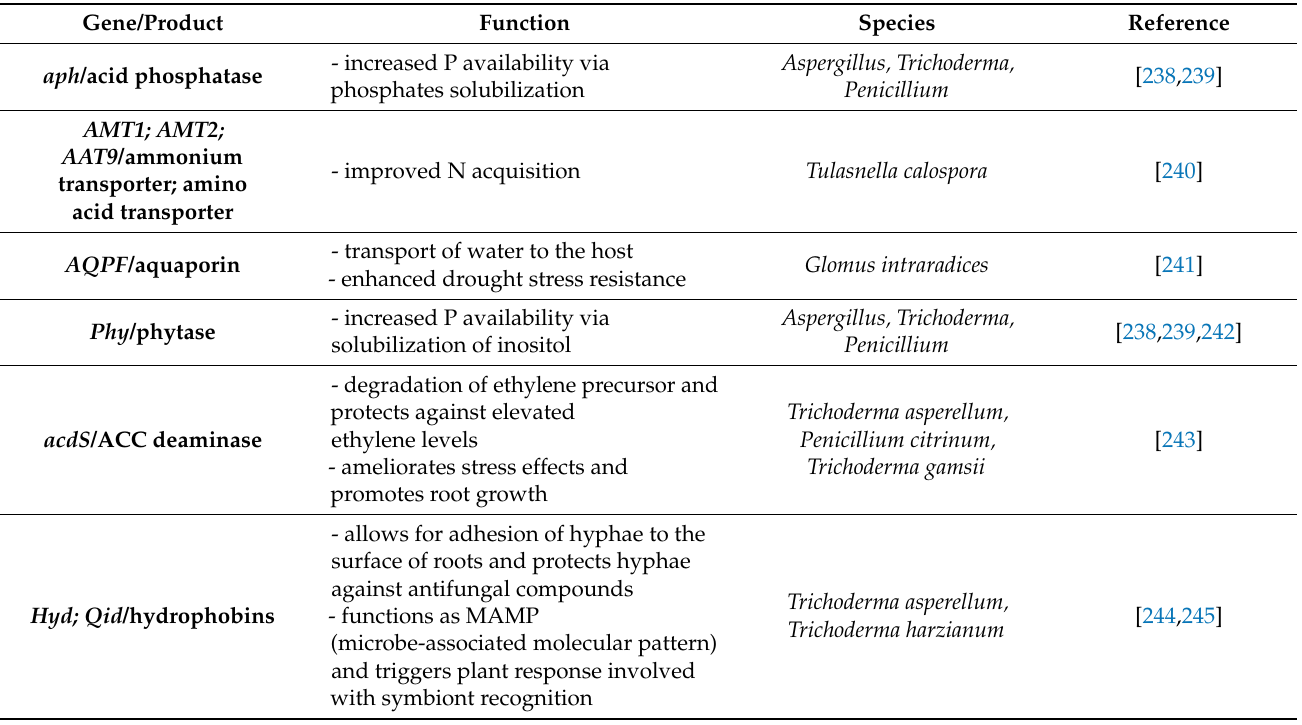
Table 2. Examples of mechanisms of plant growth promotion by